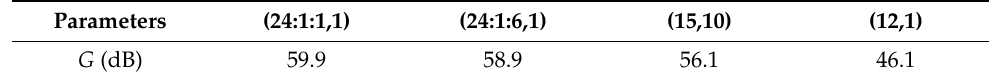
Table 5. Processing gain for the example